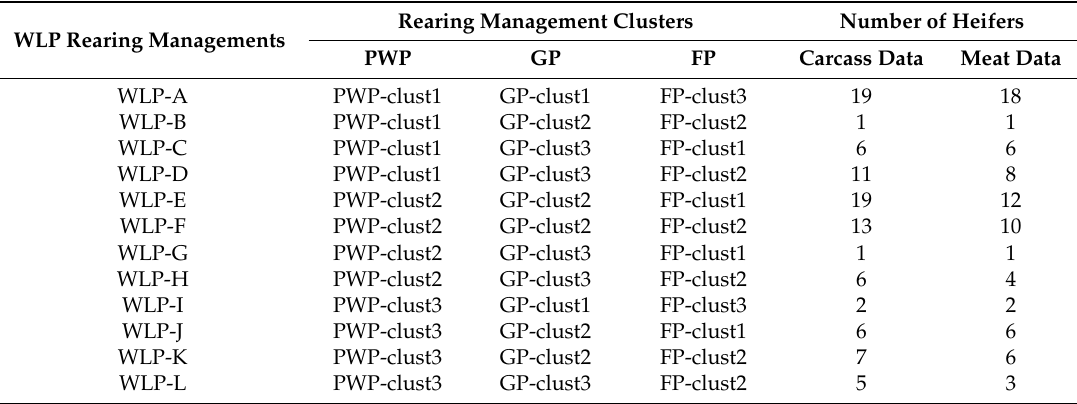
Table 4. Description of the rearing managements applied during the heifers’ whole life period